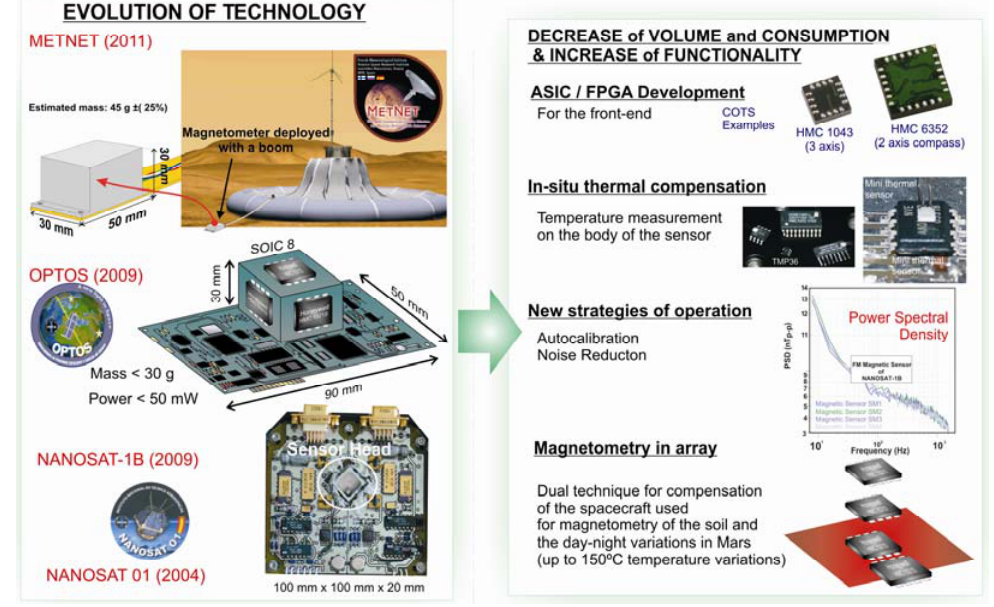
Figure 3. The graph represents the evolution of AMR-based sensors of INTA. In the right hand side of the picture the techniques used in the evolution are listed. In the left hand side of the picture the time evolution of the sensors is shown, starting in 2004 with NANOSAT- 01 and the actual goal for the MetNet Precursor